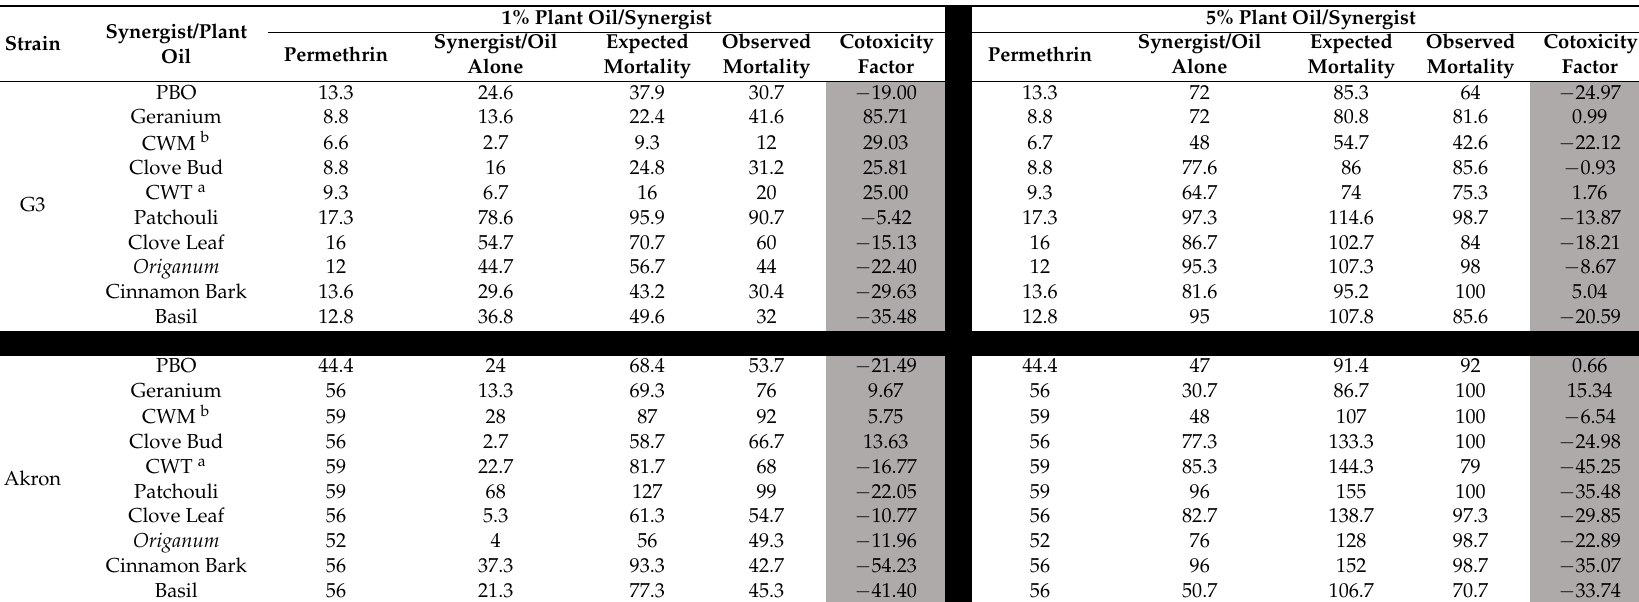
Table 4. Synergism caused by plant essential oils in combination with permethrin against An. gambiae